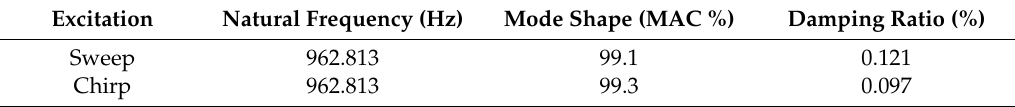
Table 2. Comparison modal parameters obtained with sweep and chirp excitation method (3rd